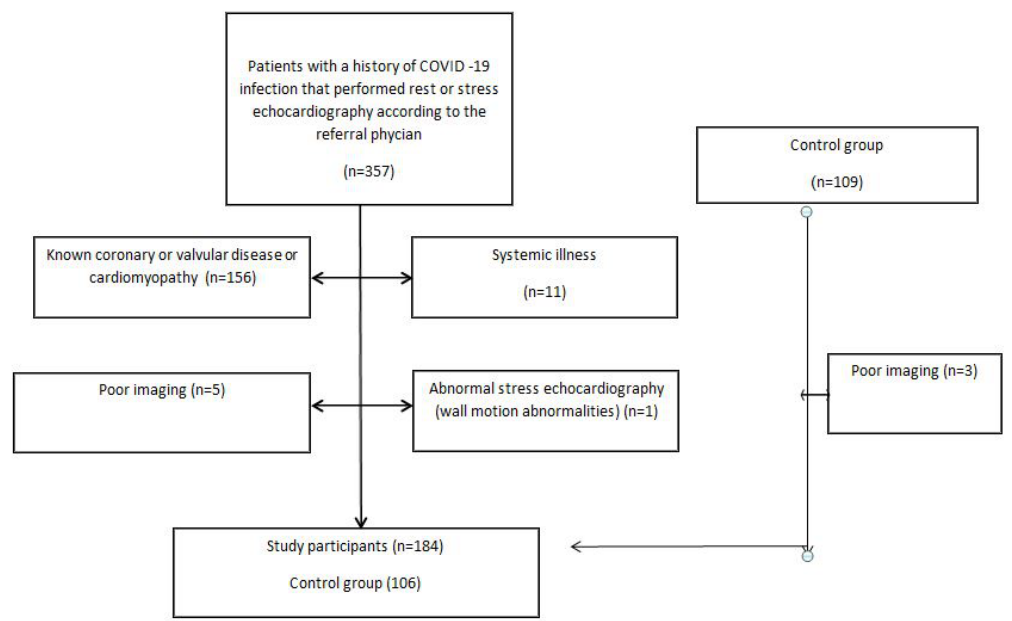
Figure 1. Patient flow through the study. Clinical and demographic data was reviewed including age, gender, and risk factors. Time of COVID-19 infection, disease severity, and the need for hospitalization and treatment were also col- lected.